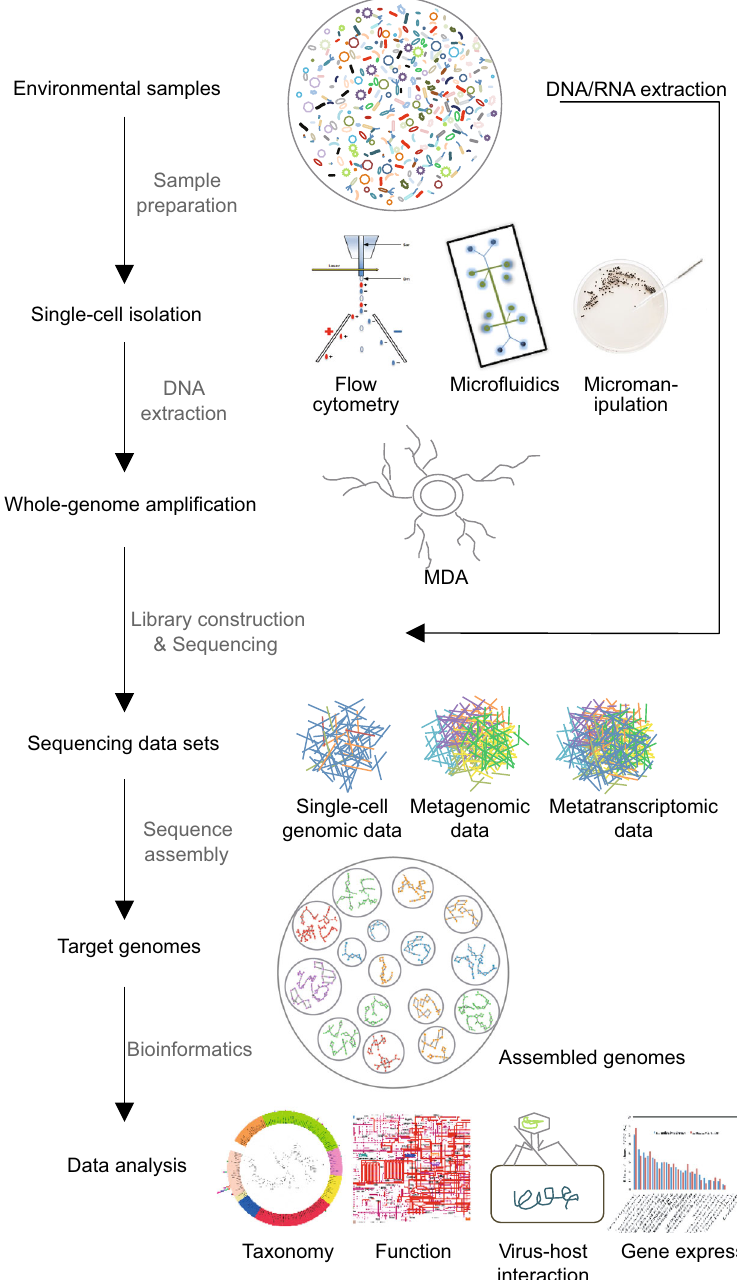
Figure 1. Work fl ow of single-cell